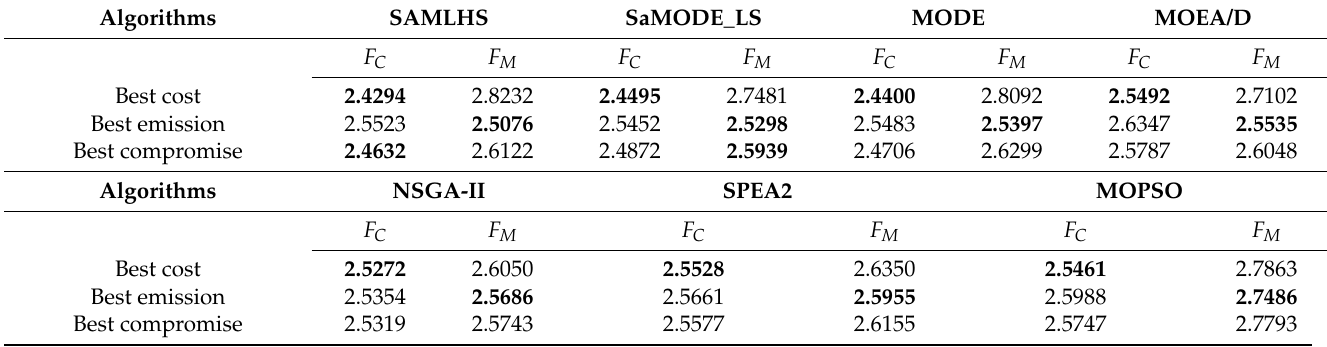
(cid:0) × (cid:1) (cid:0) × (cid:1) 10 6 $ ) and ( F M 10 5 lb